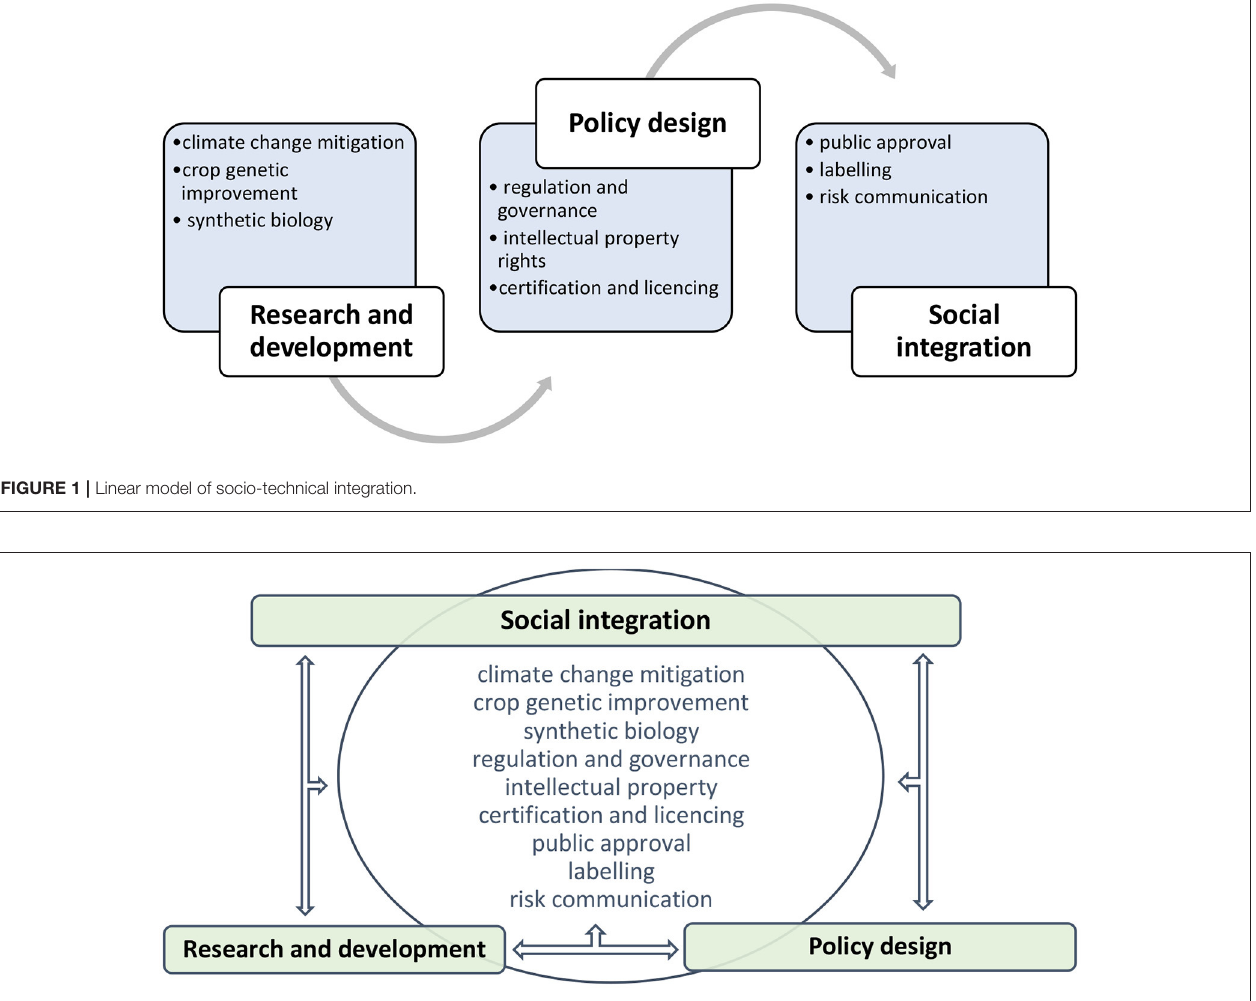
FIGURE 2 | Non-linear model of socio-technical